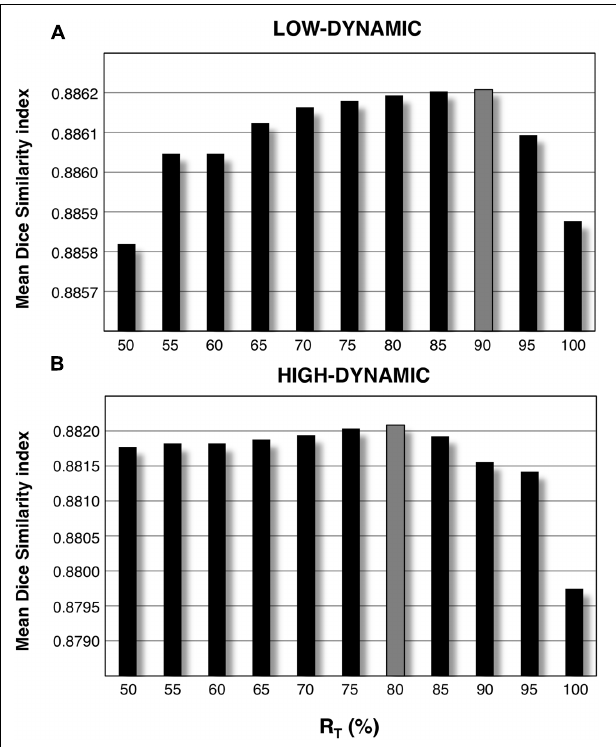
FIGURE 6 | Mean Dice Similarity Index (mDSI) threshold analysis. By defining a subset of segmented WM and GM masks corresponding to each parameter configuration and averaging them together, we generated an improved version of the same masks. This was separately done for low-dynamic (A) and high-dynamic (B) INU profiles, using a relative amount of configurations R T ranging from 50 to 100%. Each of these values represents the relative amount of included masks with respect to the total number of parameter configurations. The bar plots represent the mDSI, which quantifies the correspondence of each segmented mask with respect to the SPM template mask. The mDSI shown in figure was calculated for the two INU field profiles, averaging together the results over the whole set of simulated data (12 simulated images: 3 INU field magnitudes × 4 noise